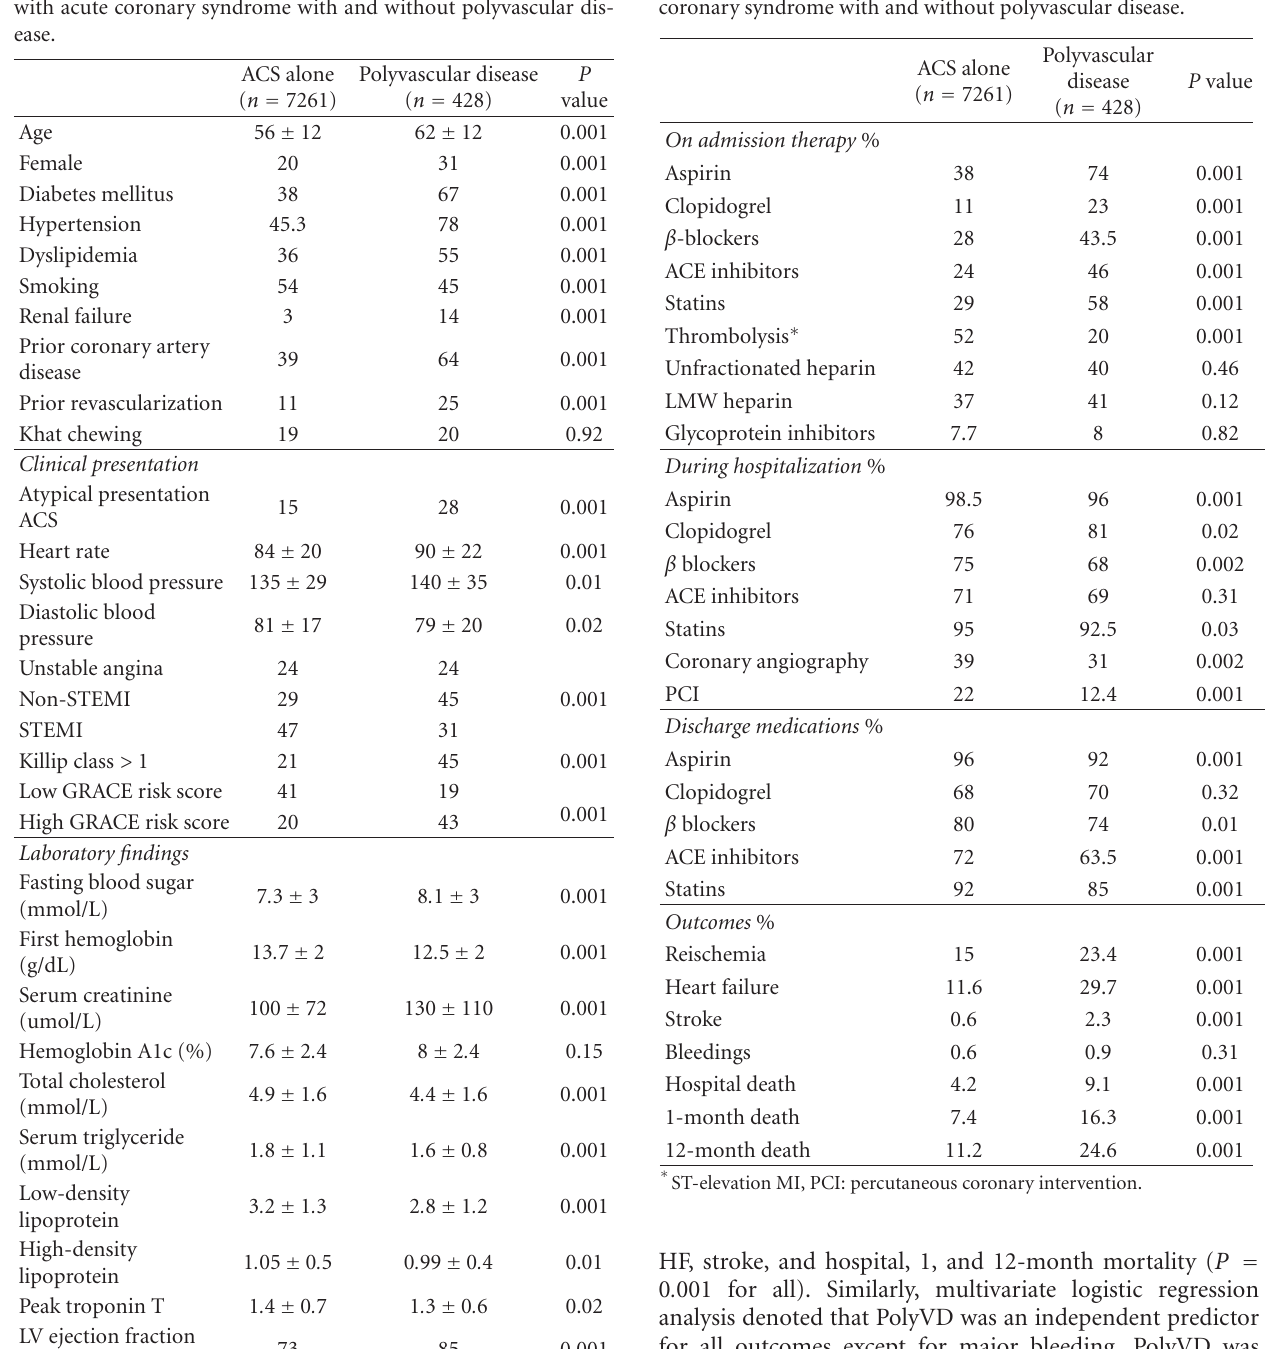
Table 2: Management and clinical outcomes in patients with acute coronary syndrome with and without polyvascular